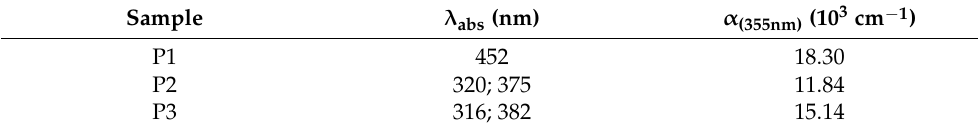
Figure 3. Normalized absorption spectra of P1 , P2 and P3 thin films. Table 1. Absorption peaks and values of absorption coefficients of P1 , P2 and P3 thin films.